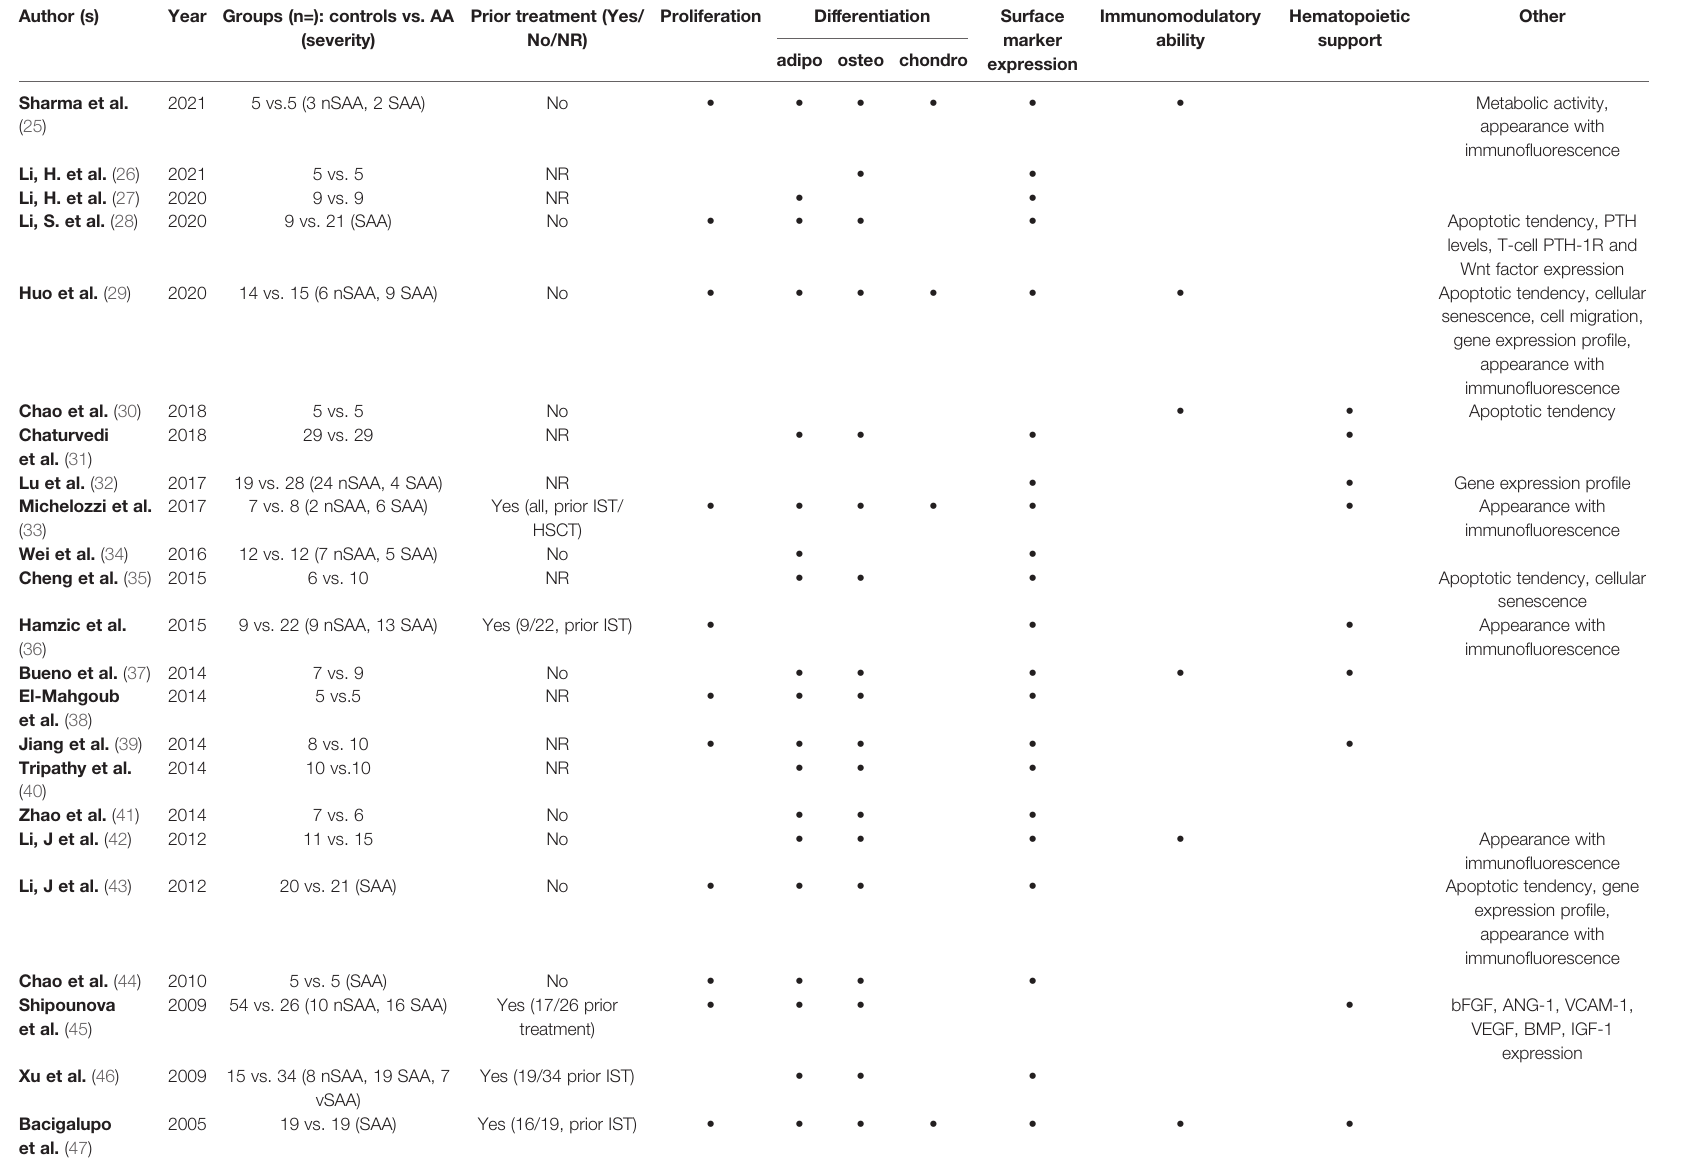
TABLE 2 | In vitro properties assessed in control and AA-MSCs. Author